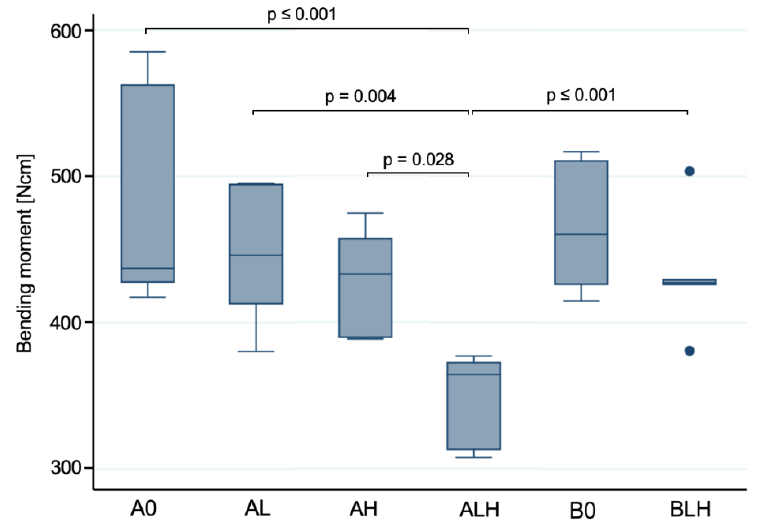
Figure 6. Boxplots showing the calculated bending moment of the static loading test (n = 7 per group; see Table 1 for detailed data). A whisker is drawn to display all samples lying within 1.5 times of